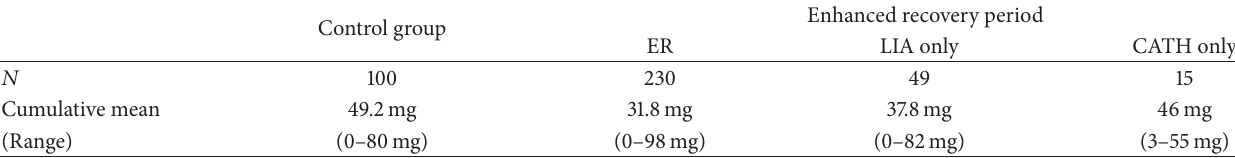
Table 4: Opiate requirement for the control group versus the enhanced recovery protocol. Patients with cognitive impairment are